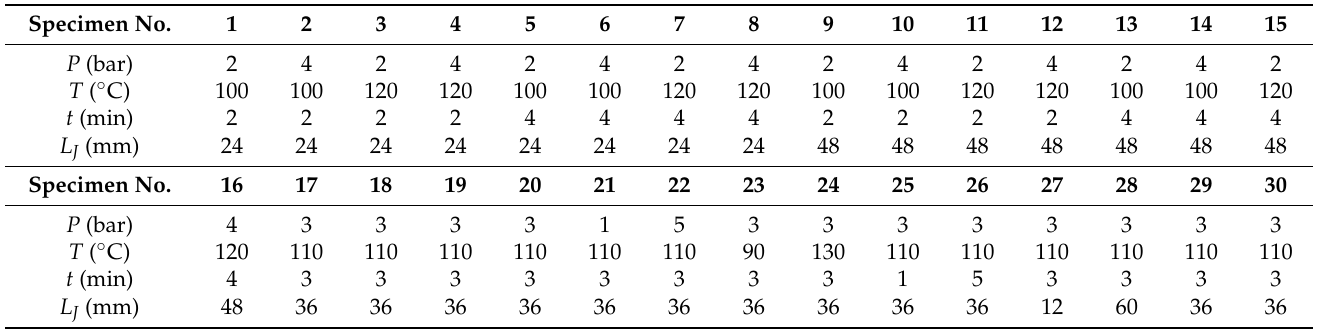
Table 2. Curing processing parameters for all specimens obtained through the response surface methodology (RSM) of design of experiment (DoE). Specimen No.